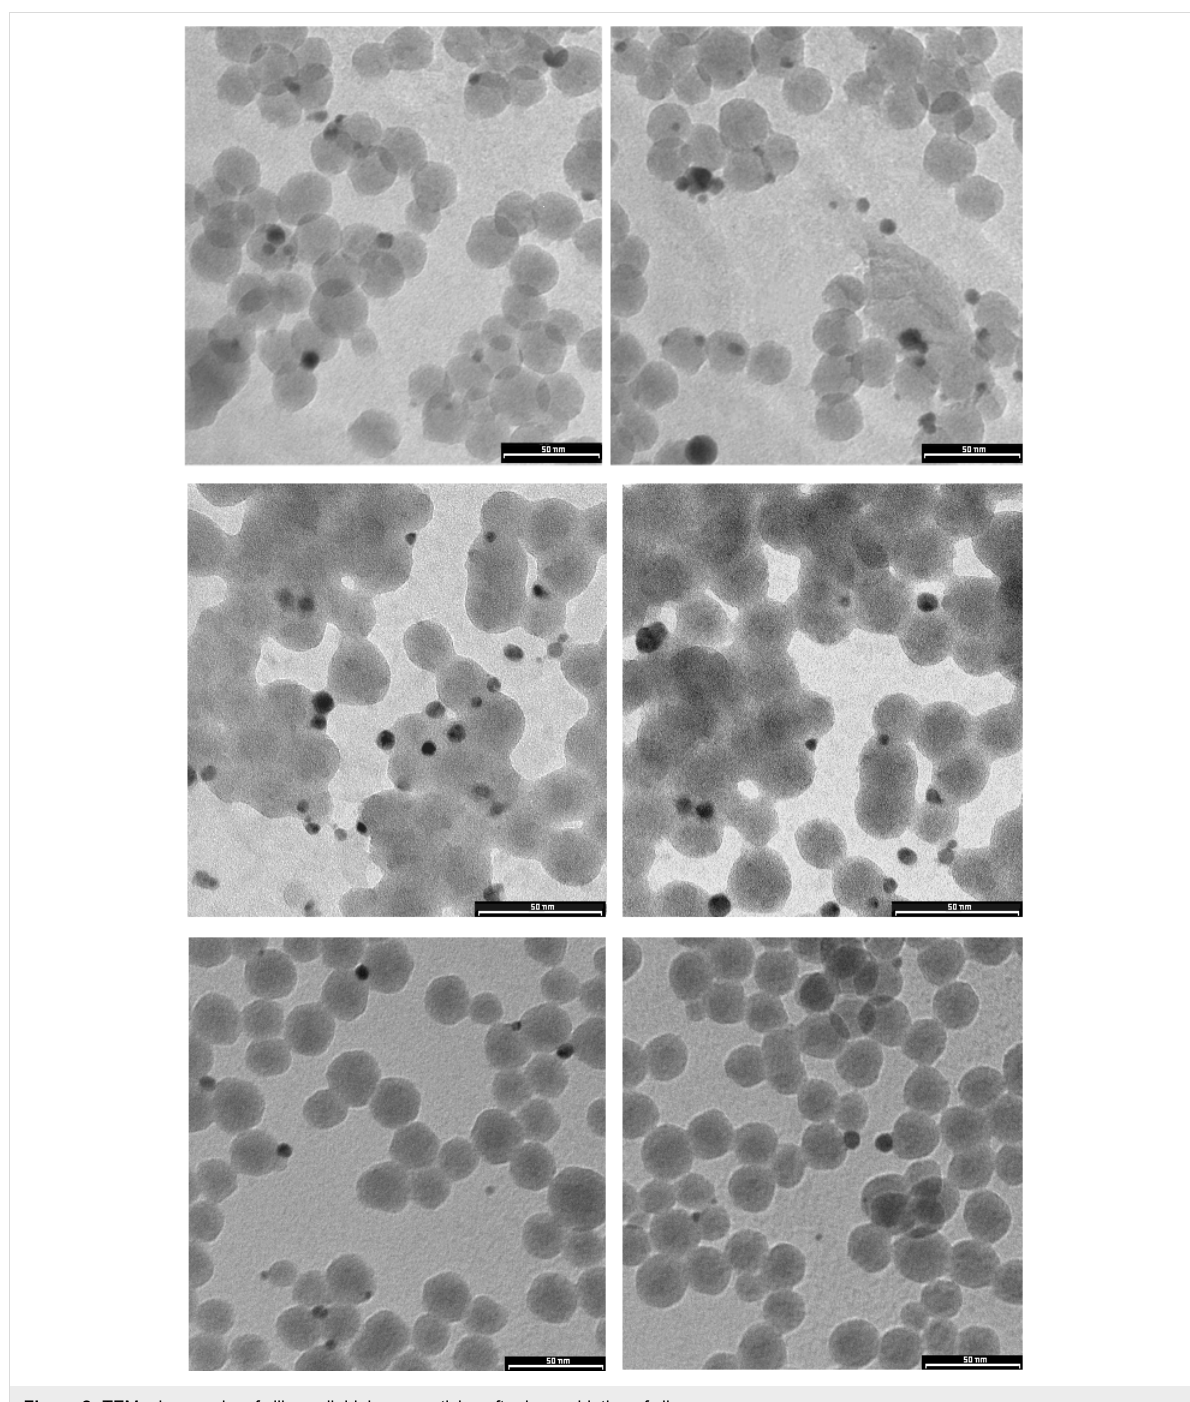
Figure 2: TEM micrographs of silica colloidal nanoparticles after laser ablation of silver.